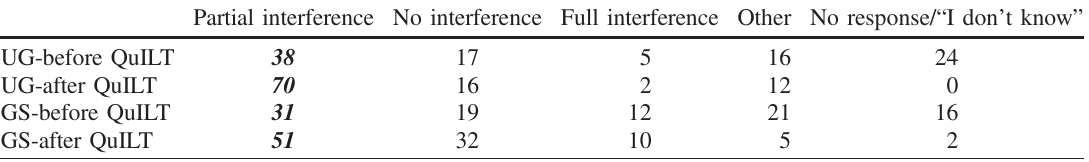
TABLE VIII. Percentages of undergraduate (UG) and graduate students (GS) with different answers on Q2 (partial interference, no interference, full interference, other, and no response/ ” I don ’ t know ” ). Bold italic indicates correct responses.